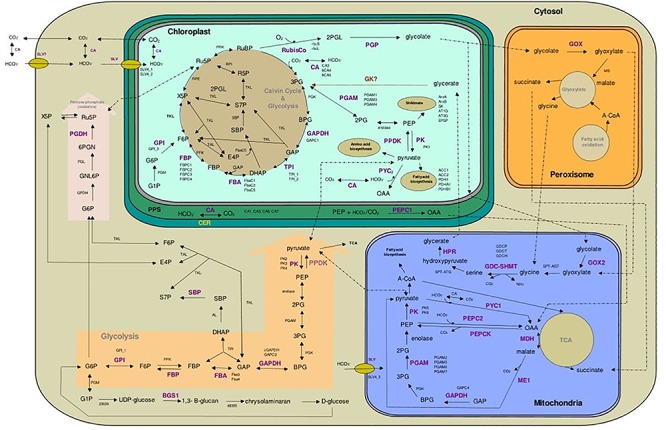
Cellular pathways and processes of central carbon metabolism in Phaeodactylum tricornutum. All red depicted enzymes are the key enzymes and their related gene/isogenes are listed beside. RUBP, D-ribulose-1,5-bisphosphate; 3PG, 3-phospho-D-glycerate; BPG, 1,3-diphosphateglycerate; GAP, D-glyceraldehyde-3-phosphate; DHAP, dihydroxyacetone phosphate; FBAC, chloroplastic fructose-1,6-bisphosphate aldolase; FBP, fructose-1,6-bisphosphate; F6P, D-fructose-6-phosphate; X5P, D-xylulose-5-phosphate; Ru5P, D-ribulose-5-phosphate; SBP, D-sedoheptulose-1,7-bisphosphate; S7P, D-sedoheptulose-7-phosphate; R5P, D-ribose-5-phosphate; E4P, D-erythrose-4-phosphate; 2PGL, 2-phosphoglycolate; 2PG, 2-phosphoglycerate; PEP, phosphoenolpyruvate; OAA, oxaloacetate; A-CoA, acetyl-CoA; G1P, D-glucose 1-phosphate; G6P, D-glucose-6-phosphate; GNL6P, D-glucono-δ-lactone-6-phosphate; 6PGN, 6-phospho-D-gluconate; PPS, periplasmic space; ER, endoplasmic reticulum (chloroplastic); ACC1, ACC2, Acetyl-CoA-carboxylase; PDH1, PDHA1, PDHB, pyruvate dehydrogenase E1; BGS1, glycosyl transferase.